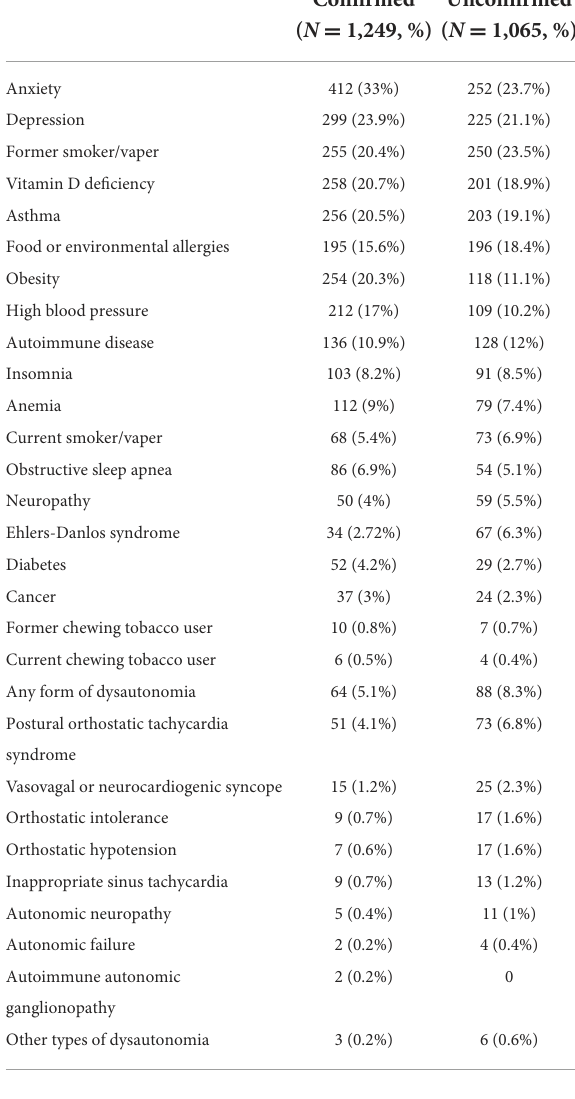
TABLE 2 Medical history of survey respondents prior to